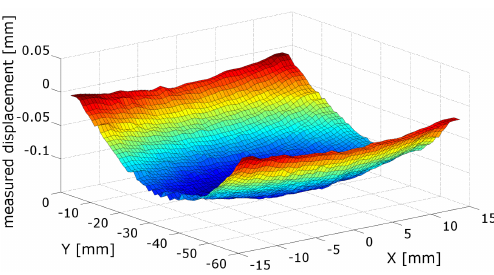
Figure 8. Cooling of specimens.